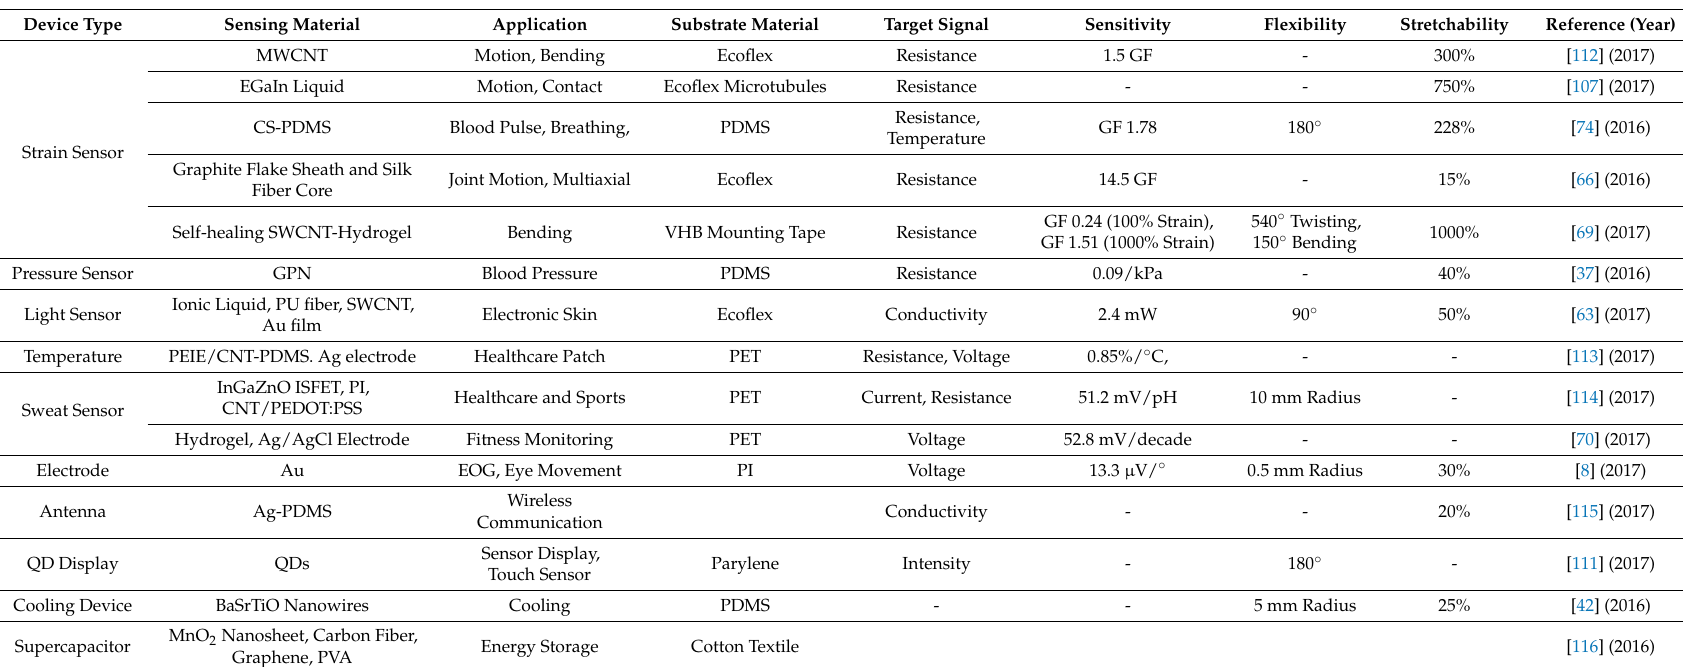
Table 3. Summary of wearable FHE, material characteristics, and